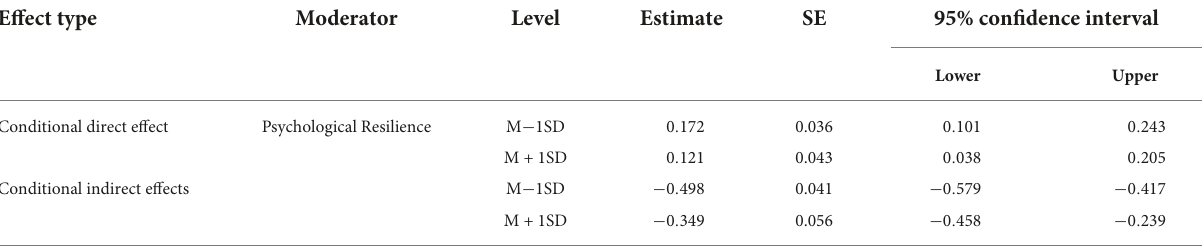
TABLE 7 Bootstrapping results for test of moderation